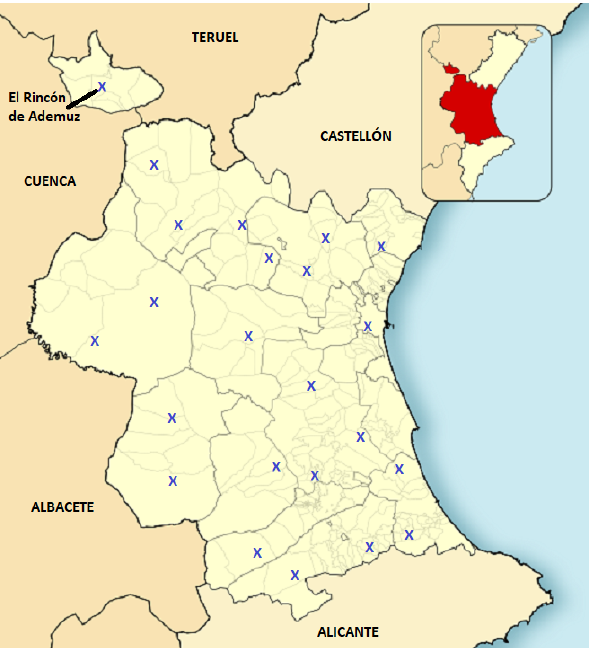
Figure 9. Distribution of forest fire stations in the province according to the proposed